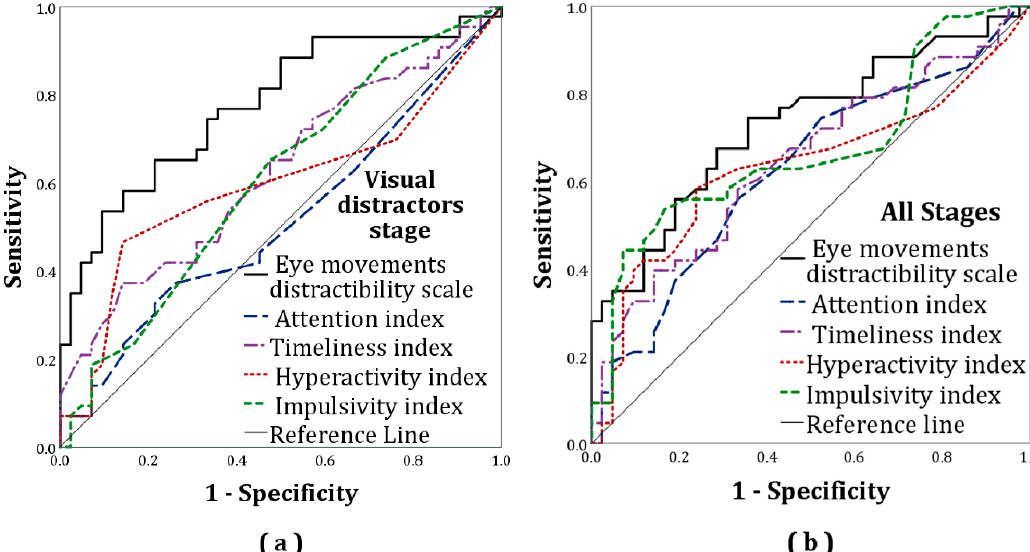
Figure 2. Receiver operating characteristic (ROC) curves for the eye movement distractibility scale